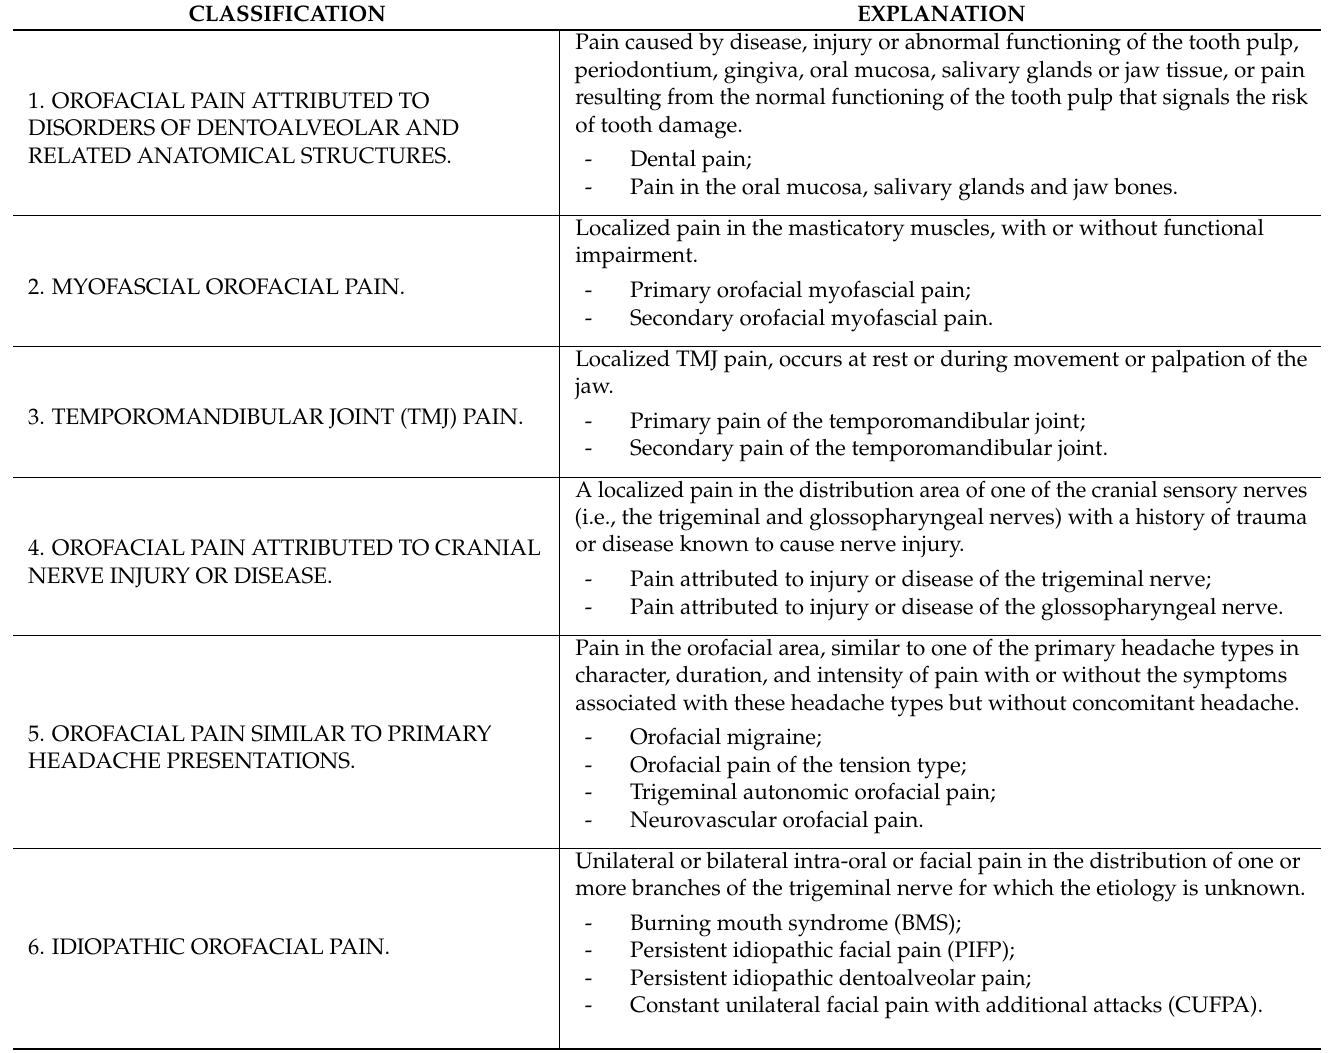
Table 1. Classification of neuropathic pain according to the ICOP 2020 classification